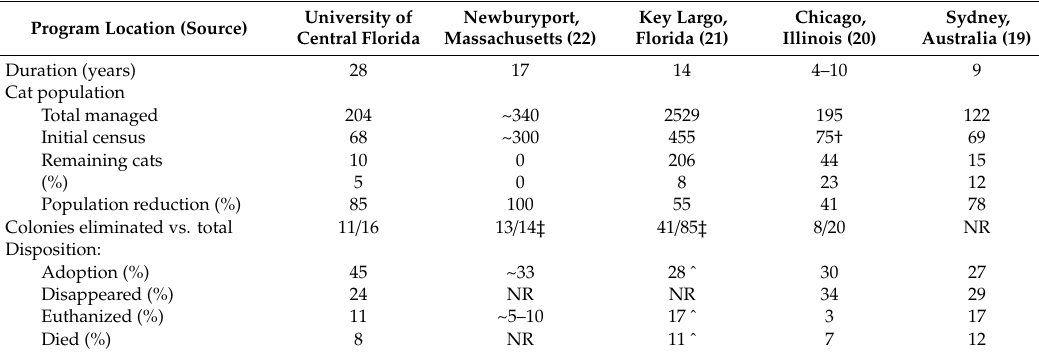
Table 4. Comparison of results from long-term TNR